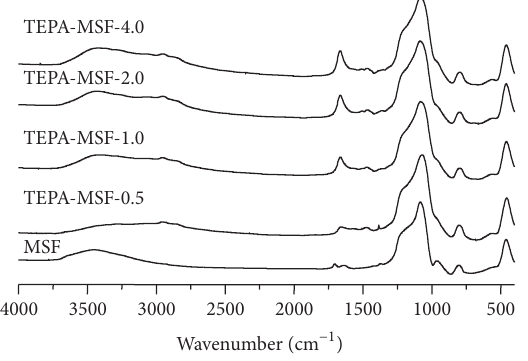
F 4: FTIR spectra of pure MSF and various TEPA-MSF- x samples.